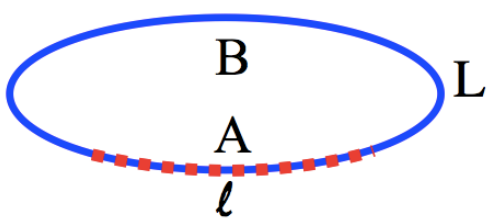
Figure 1 . Typical bipartition of a one-dimensional (cid:12)nite system of total length L into region A of length ‘ and region B of length L (cid:0) ‘